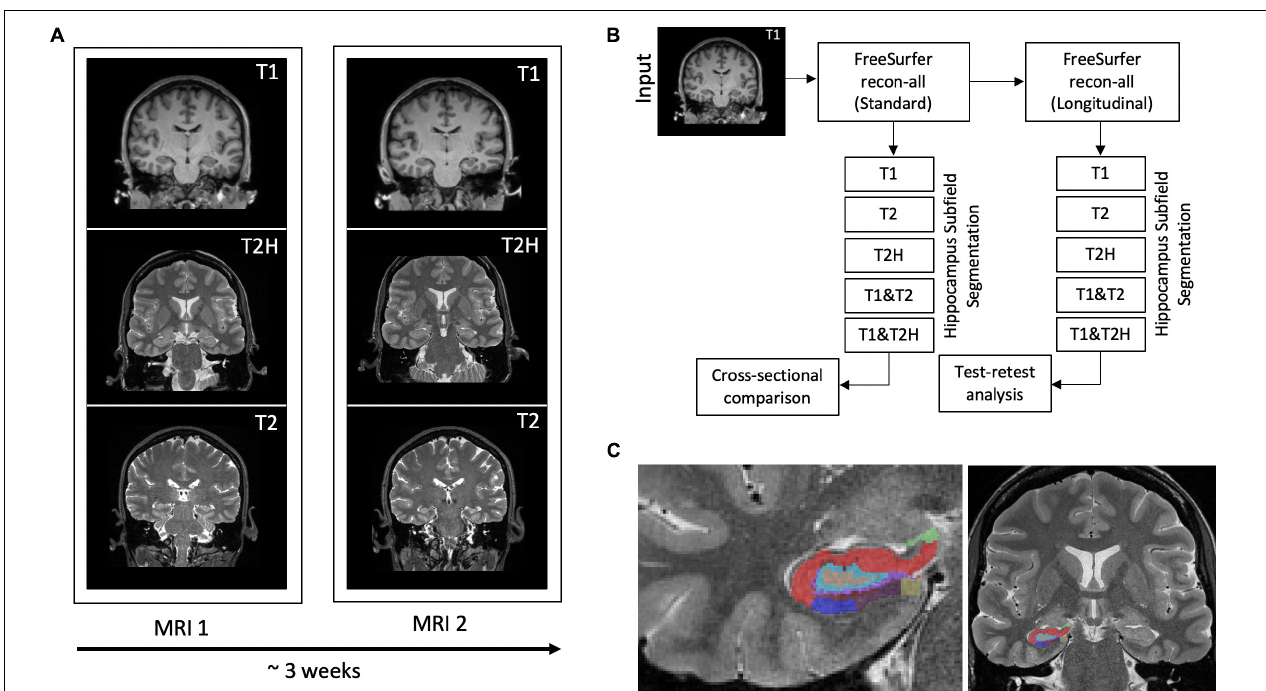
FIGURE 1 | (A) Three different MRI sequences (T1: T1-weighted, T2H: T2-weighted high-resolution and T2: T2-weighted standard resolution) were recorded for each subject at baseline and after approximately 3 weeks. (B) Depiction of the processing scheme. The T1-weighted sequence is used for the standard pipeline within FreeSurfer. All data was subsequently processed with the longitudinal stream. Hippocampus segmentation was then performed with the five different input configurations using the cross-sectionally as well as the longitudinally processed data to conduct the cross-sectional comparison and the test-retest analysis. (C) Representative hippocampal segmentation of a study participant using the high-resolution T2-weighted